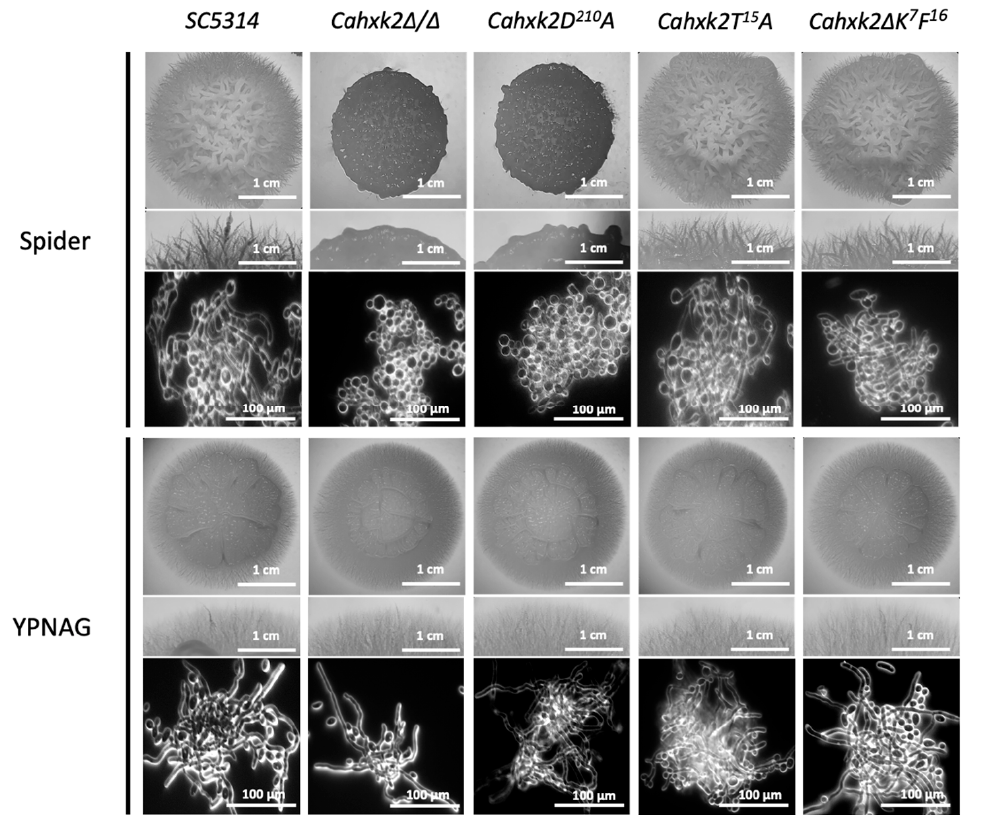
Figure 5. Filamentation of Cahxk2 mutants. C. albicans wild-type and mutant strains were grown 3 days at 37 °C on Spider and YPNAG media. For each medium the upper and middle panels show photographs of the macroscopic appearance of the colonies. The lower panels were obtained using Zeiss Askioscop 2 Plus microscope and show the microscopic aspect. Filamentation assays were repeated three times.